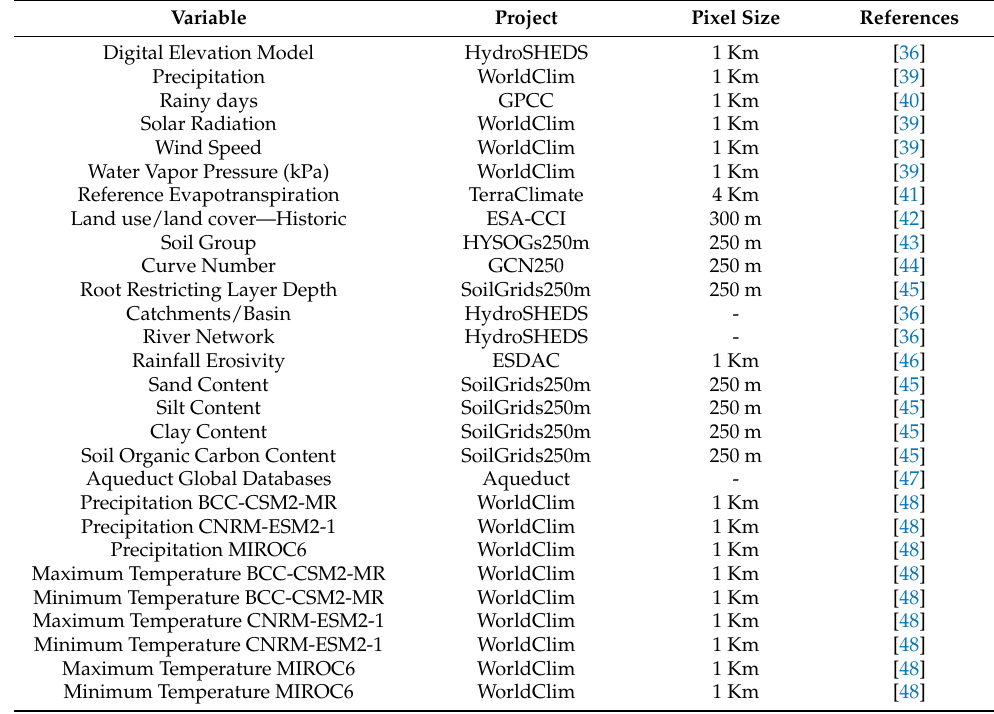
Table 13. Spatial global databases used by WaterProof .